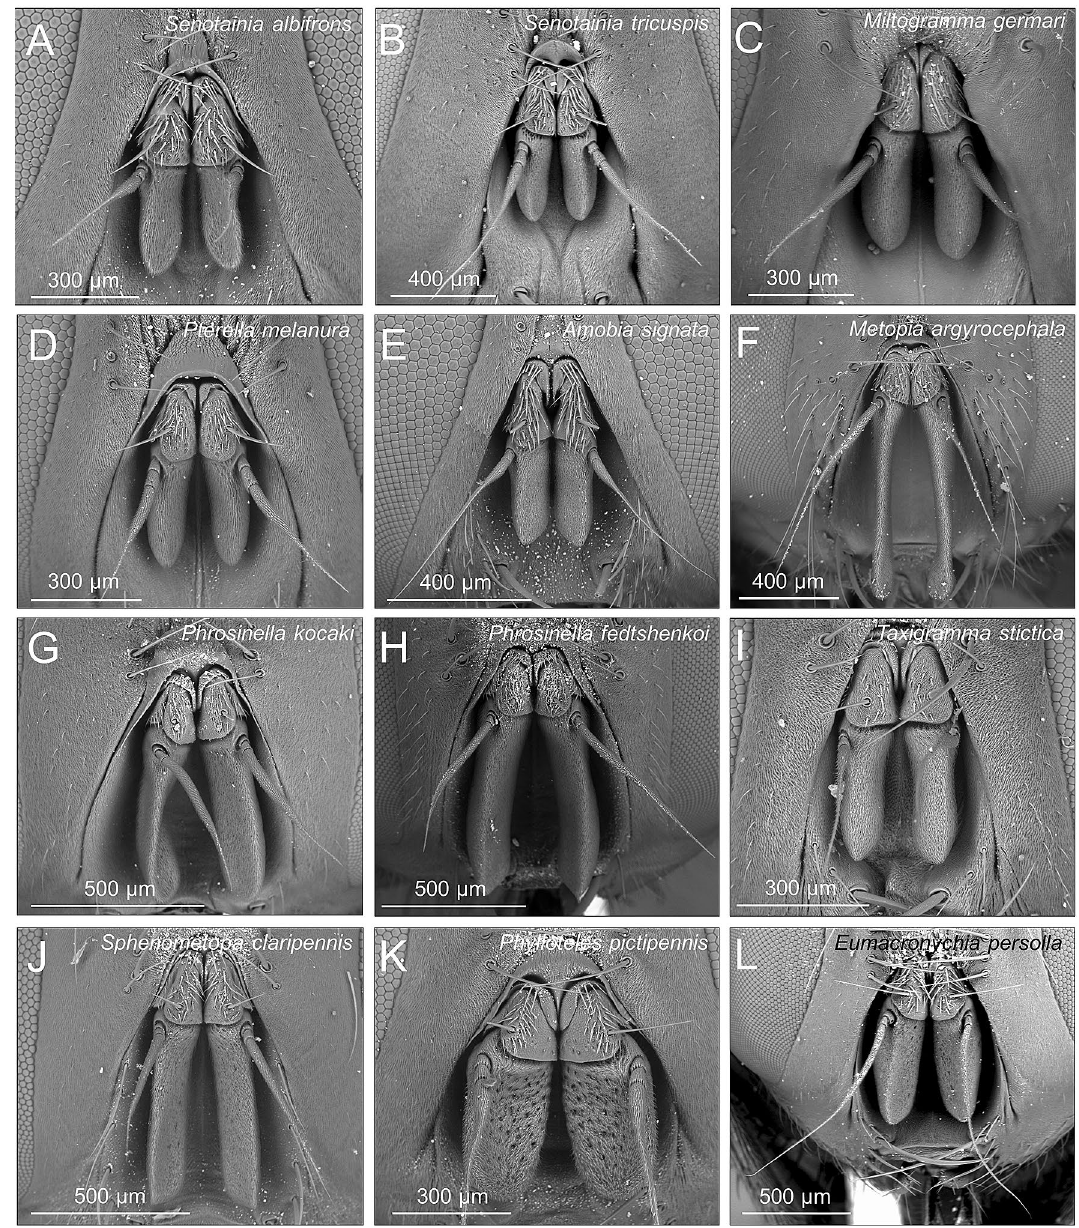
Figure 3. SEM pictures showing the variability of antenna in miltogrammine flies, as exemplified by a selection of the studied species. Head in frontal view is shown for each species. ( A ) Senotainia albifrons ; ( B ) Senotainia tricuspis ; ( C ) Miltogramma germari ; ( D ) Pterella melanura ; ( E ) Amobia signata ; ( F ) Metopia argyrocephala ; ( G ) Phrosinella kocaki ; ( H ) Phrosinella fedtshenkoi ; ( I ) Taxigramma stictica ; ( J ) Sphenometopa claripennis ; ( K ) Phylloteles pictipennis ; ( L ) Eumacronychia persolla . ( A – E ) are SAT species, ( F – L ) are NON-SAT